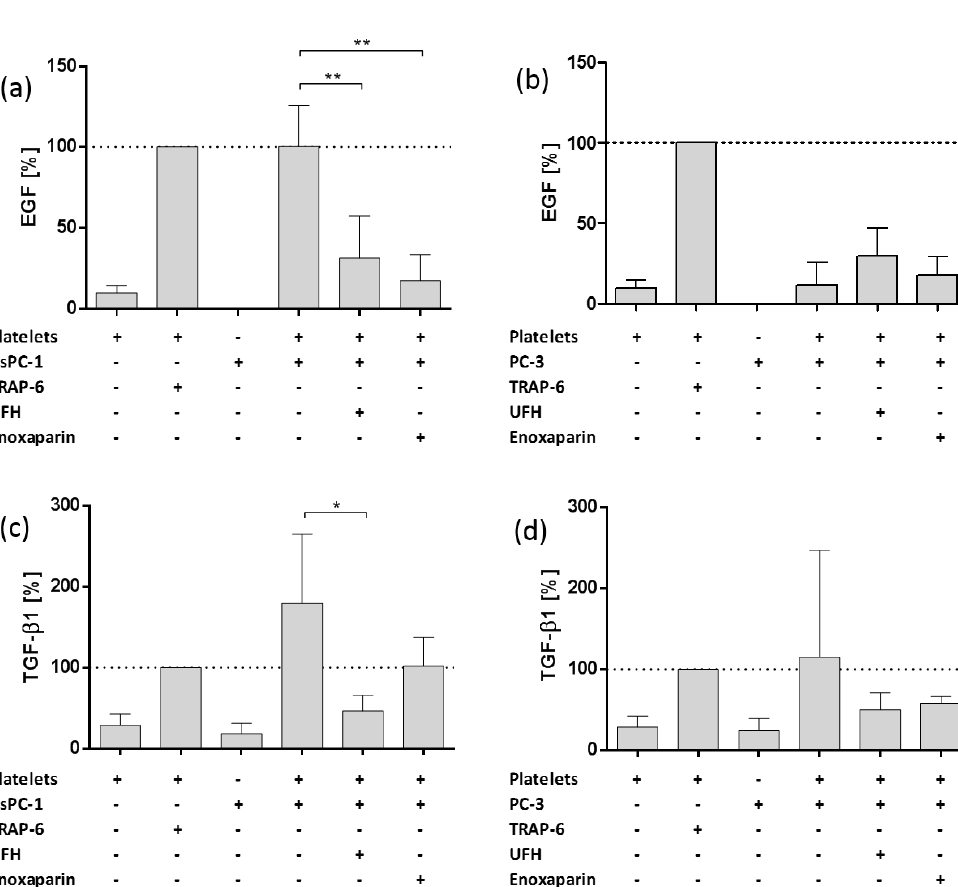
Figure 3. Impact of heparin on platelet derived EGF and TGF-β1 release. ( a ) Impact of UFH or enoxaparin on AsPC-1 cell induced EGF release from platelets. ( b ) Impact of UFH or enoxaparin on PC-3 cell induced EGF release from platelets. ( c ) Impact of UFH or enoxaparin on AsPC-1 cell induced TGF- β 1 release from platelets. ( d ) Impact of UFH or enoxaparin on PC-3 cell induced TGF- β 1 release from platelets Data are means of at least n = 3 ( ± SD), asterisks indicate statistical significance: * p ≤ 0.05; ** p ≤